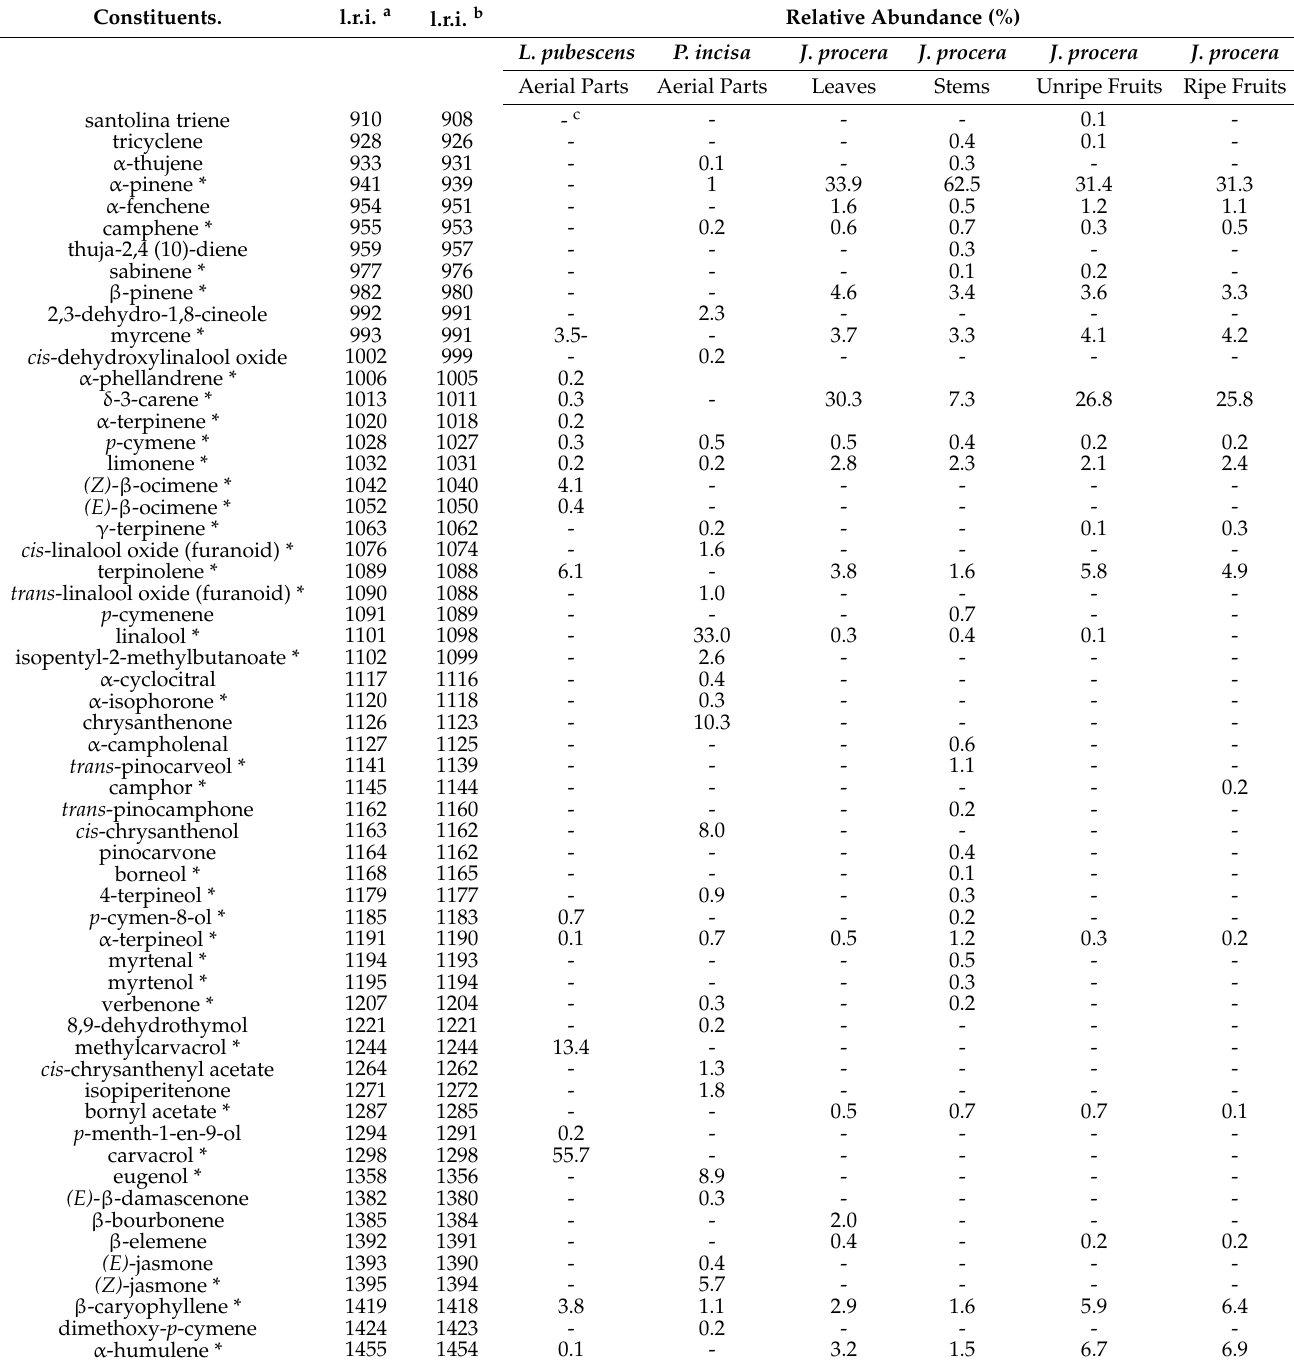
Table 1. Complete chemical composition of all the hydrodistilled essential oils.